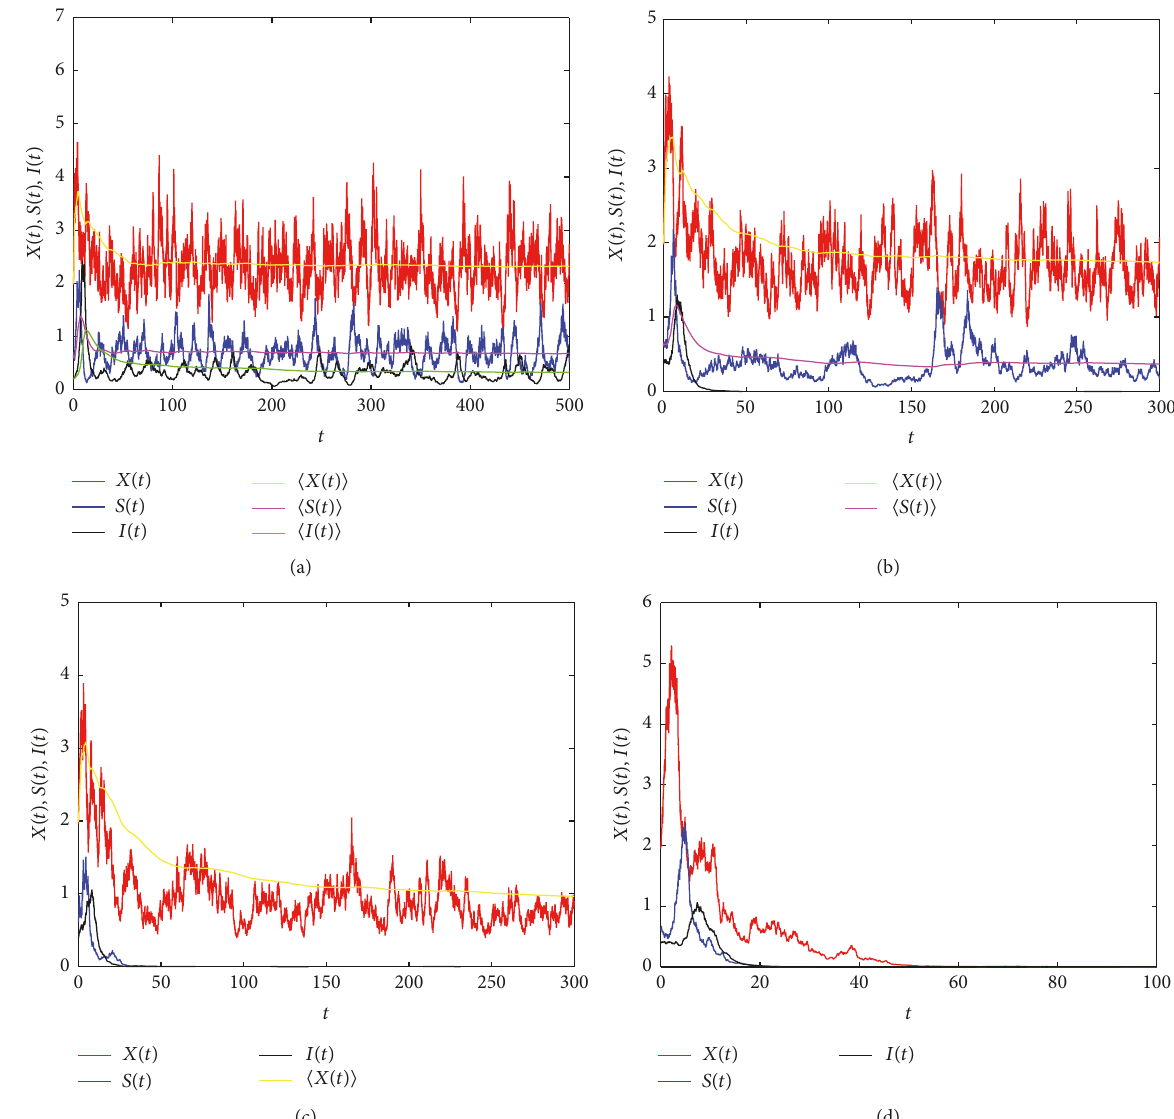
Figure 2: Keep 𝛾 1 = 0.5 , 𝛾 2 = 0.5 , 𝛾 3 = 0.1 , and 𝑇 = 1 . In (a), 𝑢 = 0.4 , 𝑋(𝑡) , 𝑆(𝑡) , and 𝐼(𝑡) are permanent, lim 𝑡→∞ ⟨𝑋(𝑡)⟩ = 2.072 , lim 𝑡→∞ ⟨𝑆(𝑡)⟩ = 0.680 , and lim 𝑡→∞ ⟨𝐼(𝑡)⟩ = 0.345 ; in (b), 𝑢 = 0.6 , 𝑋(𝑡) and 𝑆(𝑡) are permanent, 𝐼(𝑡) is extinct, lim 𝑡→∞ ⟨𝑋(𝑡)⟩ = 1.719 , and lim 𝑡→∞ ⟨𝑆(𝑡)⟩ = 0.313 ; in (c), 𝑢 = 0.8 , 𝑋(𝑡) is permanent, 𝑆(𝑡) and 𝐼(𝑡) are extinct, and lim 𝑡→∞ ⟨𝑋(𝑡)⟩ = 0.952 ; in (d), 𝑢 = 1 and then the species are